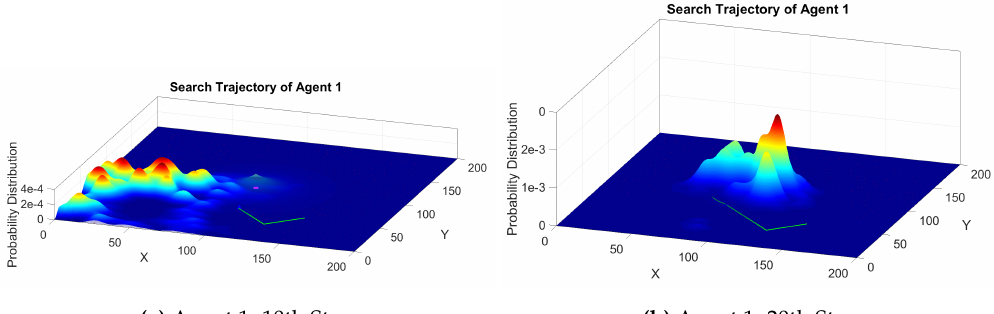
Figure 8. 3D probability distribution estimated over the possible positions of the dispersion source by the Robot 1 (( a ) 10th Step; ( b ) 20th Step). No particle is lost in the estimation process, and the incoming information stream is used to adjust the weights of the Gaussian